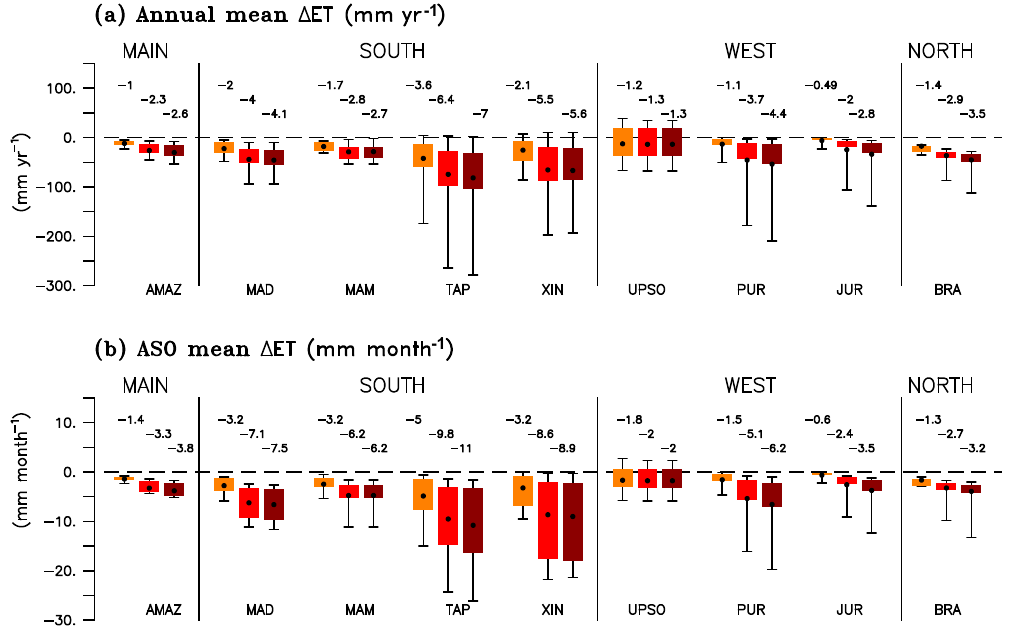
Figure 8. (a) Mean annual (mmyr − 1 ) and (b) ASO values (mmmonth − 1 ) of ET changes due to deforestation and assuming future climate change, for the end of the century, over the Amazon Basin and eight of its catchments (the abbreviations of the catchments are indicated in Table S1). Each box plot corresponds to the interquartile range (IQR, distance between the 25th and the 75th percentiles) within each catchment indicating the spread of the three GCM forcings × three LSMs results for one LCC scenario (see Fig. 6 for colour code). For a given box plot, the black points denote the mean value over the catchment, the whiskers extend from the minimum value to the maximum one and the numbers above the box plot indicate the mean relative differences over the catchment